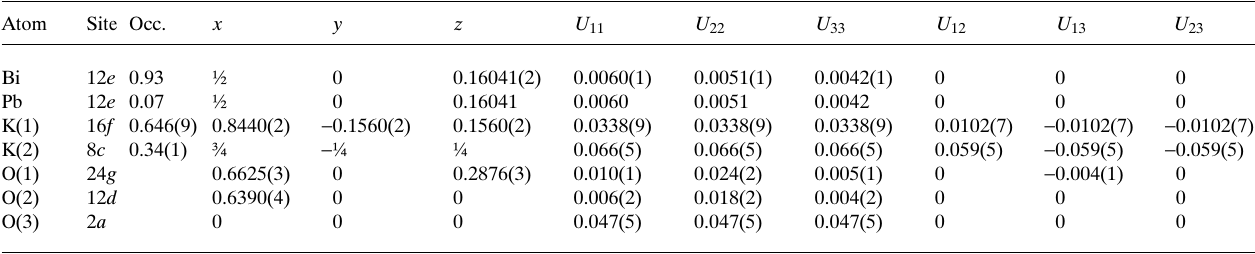
Table 2. Atomic coordinates and displacement parameters (in Å 2 )